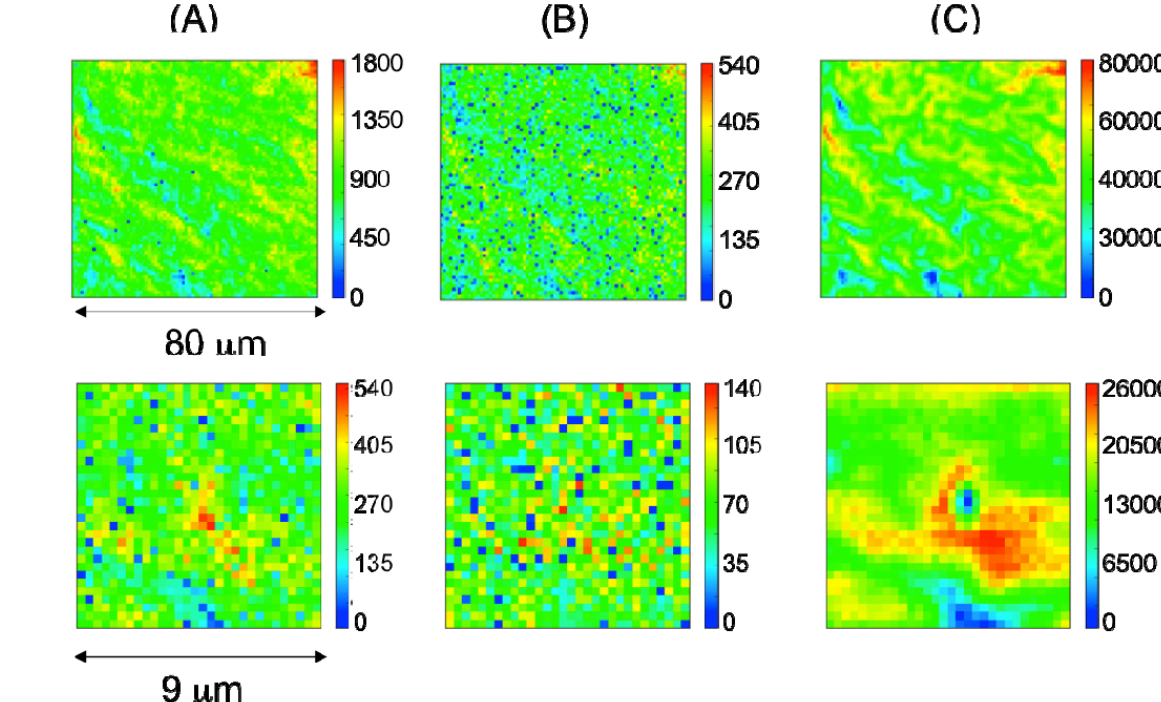
Figure 4. XRF maps of electrodeposited Mn–Co–Mg/PPy composites (energy: 1.4 keV, step size: top 1 μ m, bottom 0.3 μ m): ( A ) Mn; ( B ) Co; ( C )